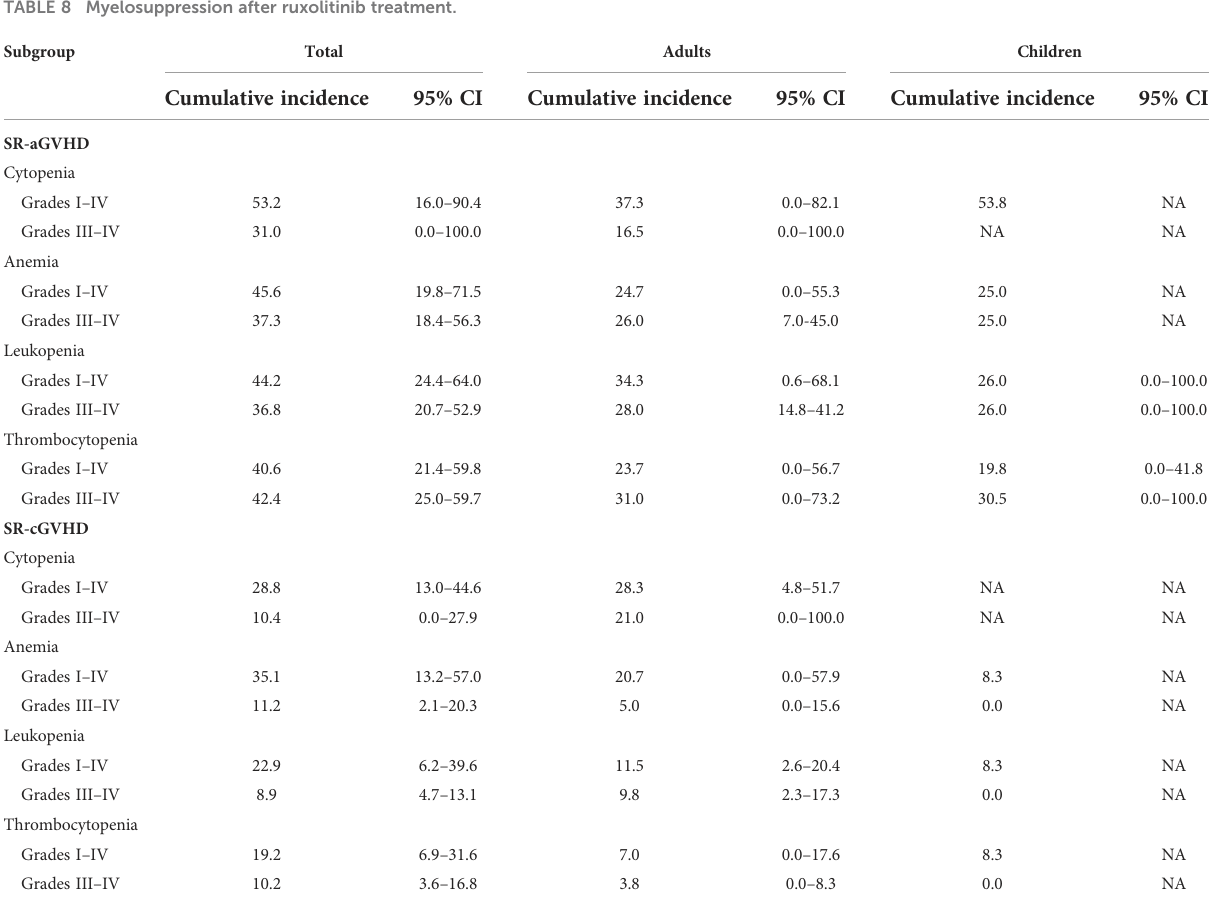
TABLE 8 Myelosuppression after ruxolitinib